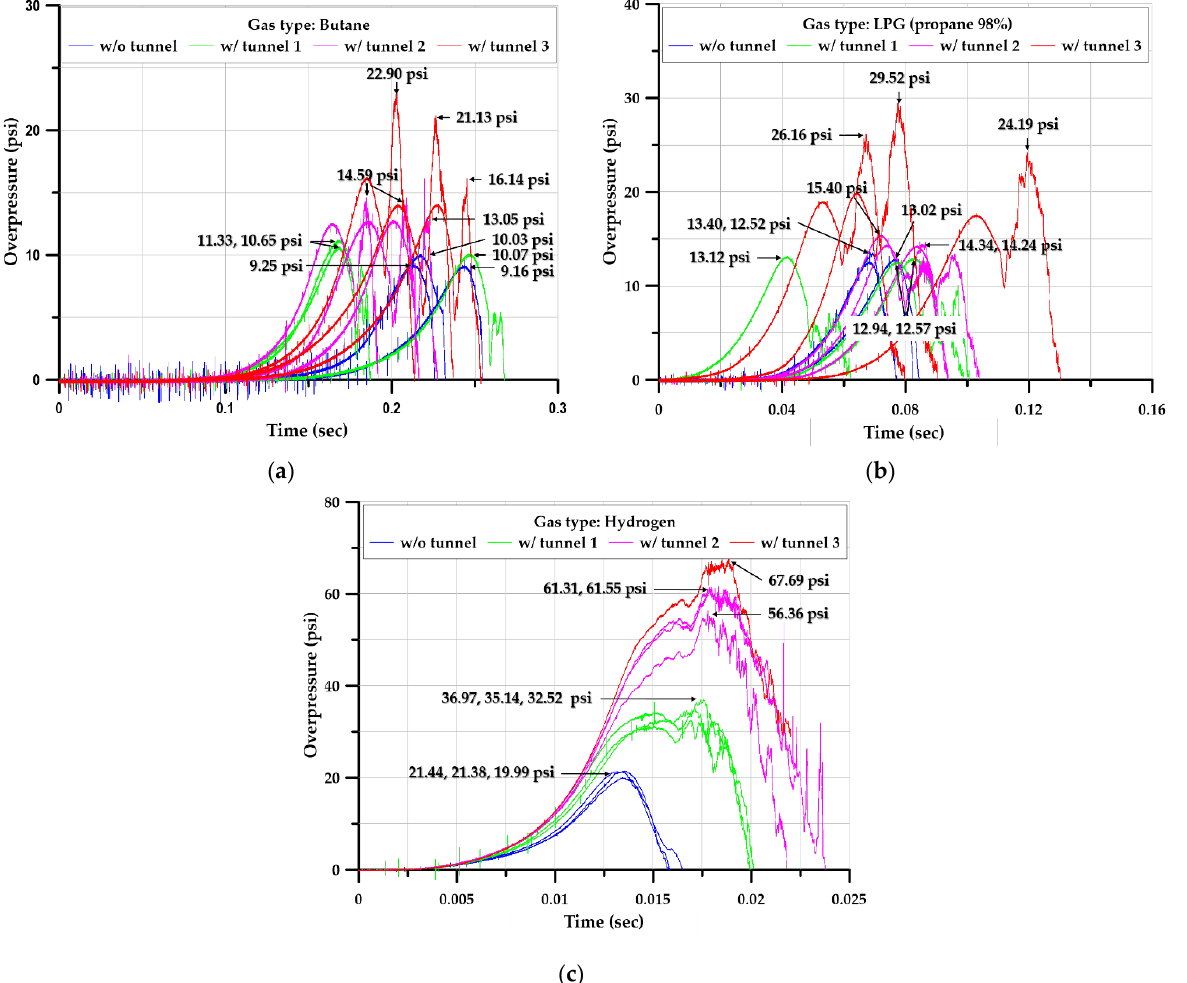
Figure 16. Time – pressure profiles inside the square-type chamber with and without tunnels; ( a )Bu- Figure 16. Time–pressure profiles inside the square-type chamber with and without tunnels; tane, ( b ) LPG (propane 98%), ( c ) Hydrogen . ( a )Butane, ( b ) LPG (propane 98%), ( c ) Hydrogen.